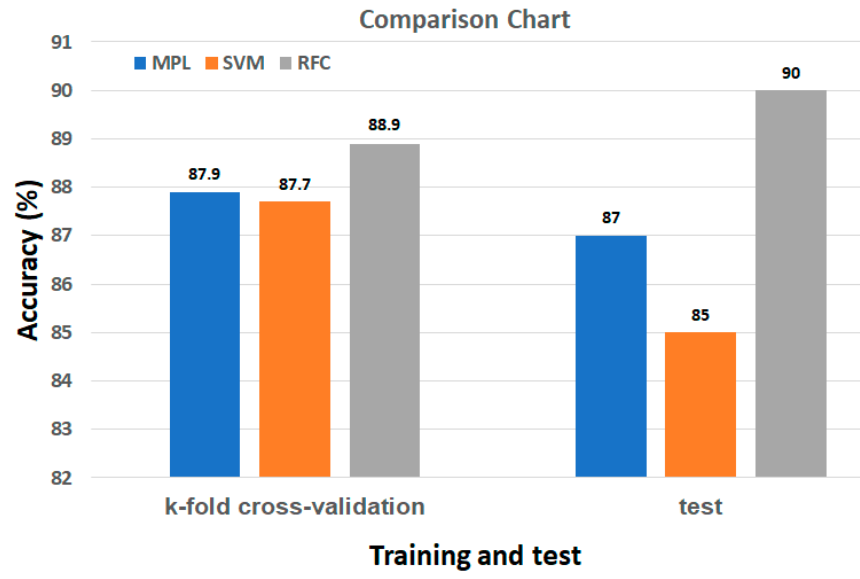
Figure 6. Comparison chart of K -fold cross-validation results and prediction of test data.